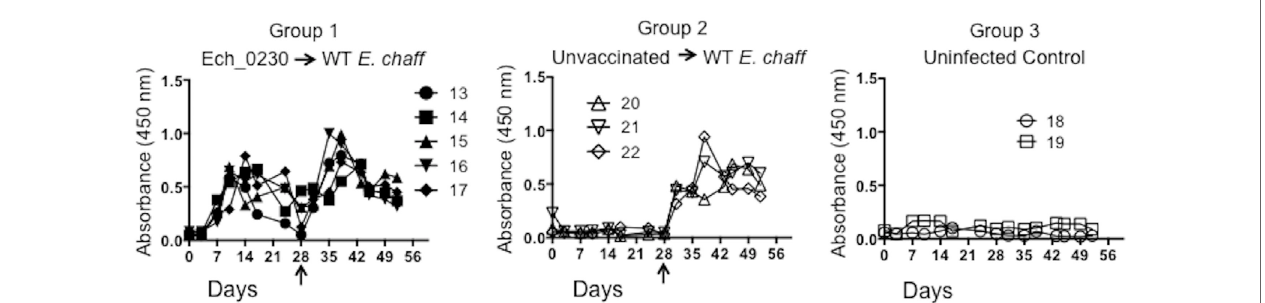
FigUre 1 | Ehrlichia chaffeensis- specific IgG response following Ech_0230 vaccination and secondary challenge with wild-type E. chaffeensis . Total E. chaffeensis - specific IgG was measured in the serum at multiple time points by ELISA in dogs vaccinated with the Ech_0230 mutant and challenged with wild-type E. chaffeensis (group 1), in unvaccinated control dogs that were infected with wild-type E. chaffeensis (group 2), and in uninfected negative control dogs (group 3). Dogs in groups 1 and 2 were challenged with virulent E. chaffeensis on day 28 post infection (indicated by the arrow). Each line is representative of a single animal. The data are not significantly different between groups as determined using two-way ANOVA with Sidak’s multiple comparisons